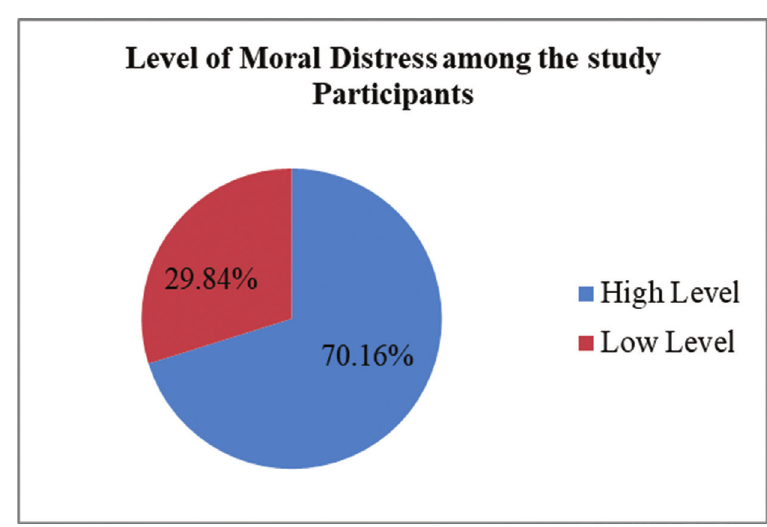
Figure 1. Level of moral distress among nurses working at Jimma University Medical Center, Jimma Zone, Jimma Town, South West Ethiopia, April 2019 ( n = 248).